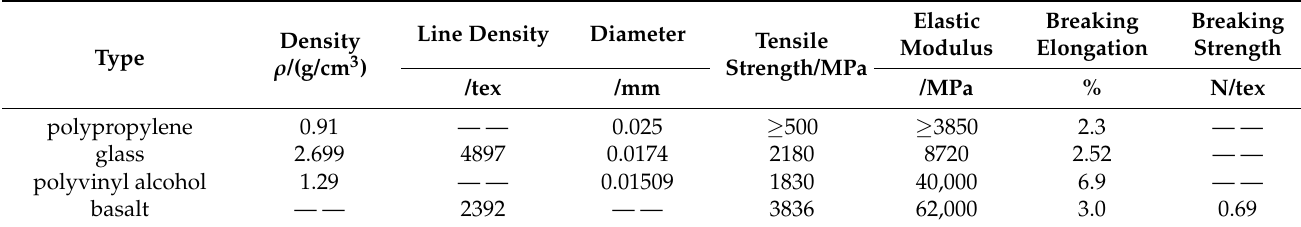
Table 1. Physicomechanical behaviors of fibers.